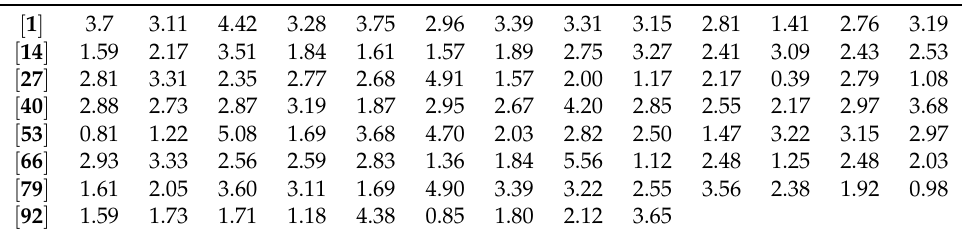
Table 21. The practical data sets of tensile strength of carbon fibers.